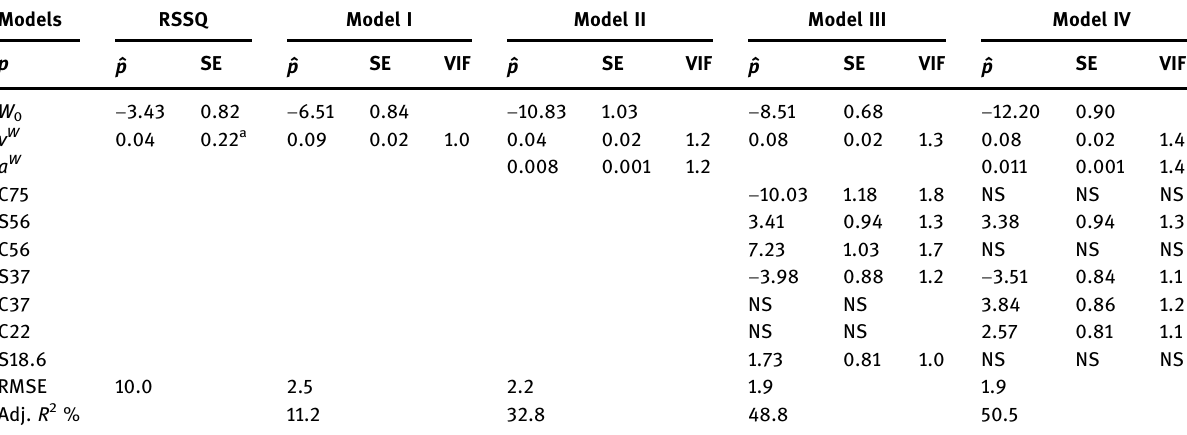
Table 2: The RSSQ of misclosure of the budget component velocities and the solution statistics for four di ff erent models are tabulated. The unit for the velocity and uniform acceleration are in mm/year and mm/year 2 , respectively. The units of all other estimates are represented in mm. Adj. R 2 is represented in percent. RSSQ velocity misclosure is quoted from the study by Frederikse et al. ( 2020